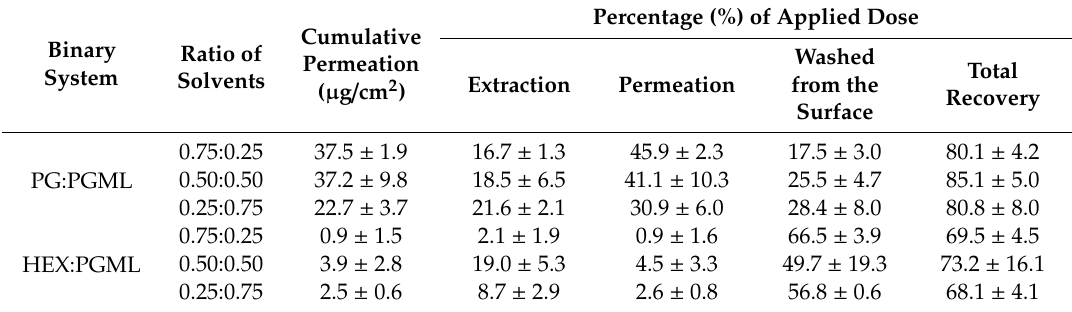
Table 1. Cumulative permeation and percentage (%) recovery values of EA for various PG:PGML and HEX:PGML solvent systems following mass balance studies ( n ≥ 3; mean ±